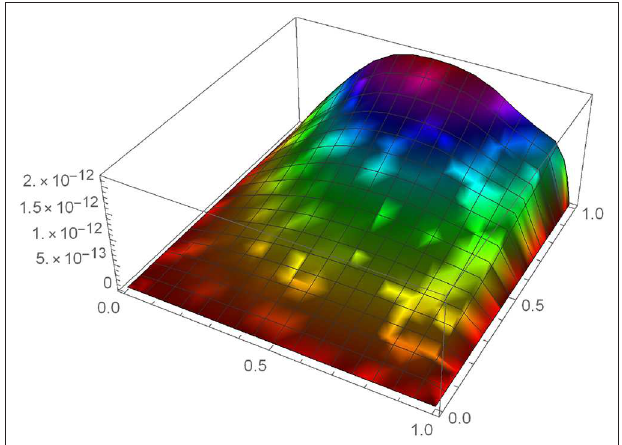
FIGURE 1 | 3D-plot of absolute error for m = 10.